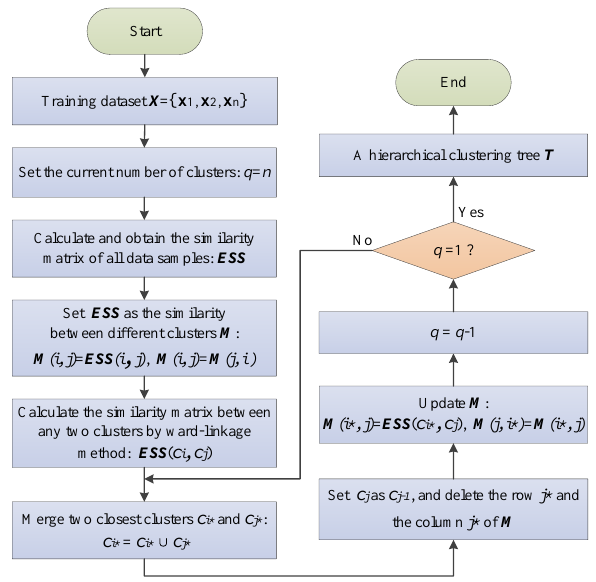
Figure 2. Flow diagram of the hierarchical clustering (HC) algorithm.